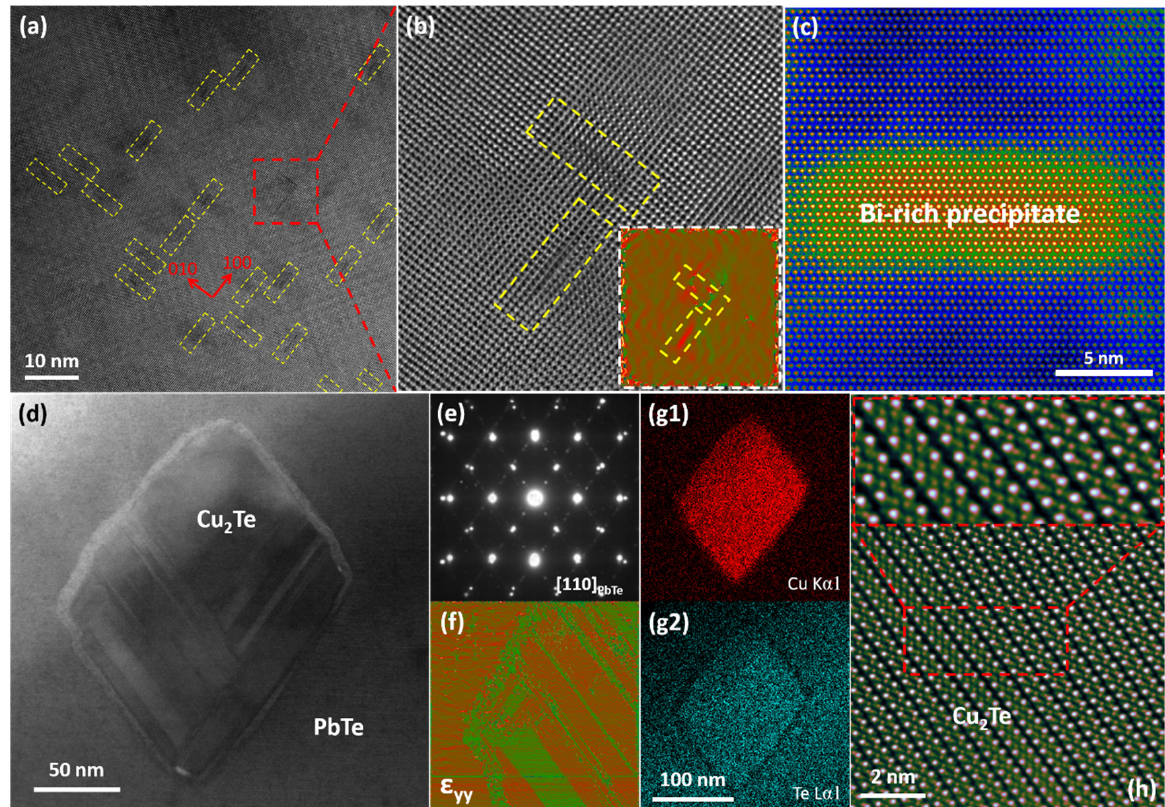
Figure 7. Nanoscale precipitates of thermoelectric materials. ( a ) HRTEM image of platelet-like nanostructures. ( b ) Enlarged lattice image of two perpendicular platelet-like nanostructures, with GPA strain analysis inset. Reproduced from Ref. [4] Copyright 2017, American Chemical Society. ( c ) STEM HAADF image of one Bi-rich precipitate with Mg 3 Sb 2 based matrix. Reproduced from Ref. [167] Copyright 2018, Elsevier. ( d ) Low-mag STEM ABF image of a cubic Cu 2 Te precipitate within PbTe matrix. ( f ) Fast Fourier transformation (FFT) image and GPA strain analysis of a Cu 2 Te-PbTe interface. ( g1 , g2 ) EDS elemental mapping of the Cu 2 Te precipitate. ( h ) Obtained STEM HAADF image of Cu 2 Te layered structure simultaneously, with amplified images around the stacking faults inset. Reproduced from Ref. [4] Copyright 2017 American Chemical